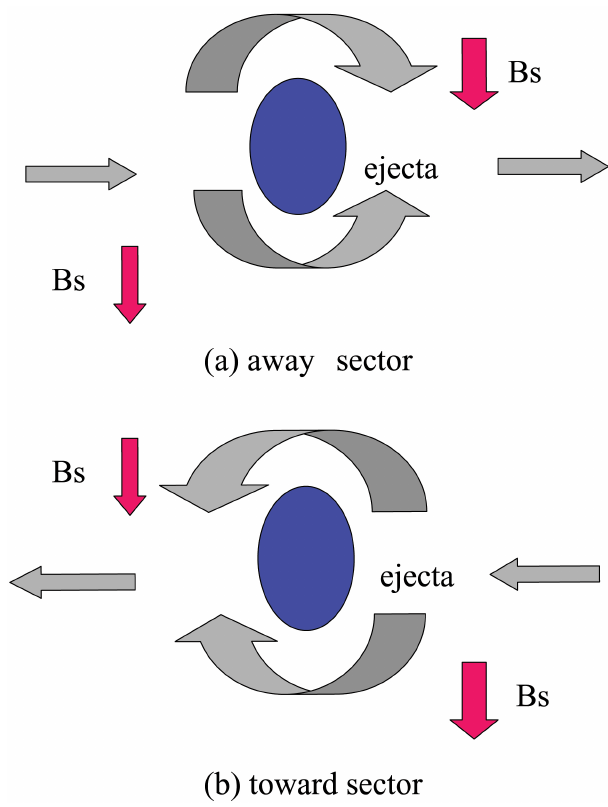
Fig. 13. Formation of southward IMF through the interaction be- tween ejecta and IMF of the background solar wind. The upper panel shows the away sector and the lower panel shows the toward sector. The Sun is on the left-hand side, right is the direction to- wards the Earth, the horizontal gray arrow indicates the direction of the interplanetary magnetic field, the broad gray arrows indicate the direction of the field draped around the ejecta. The ejecta travel from the left side to the right side in this figure. “ Bs ” means south- ward